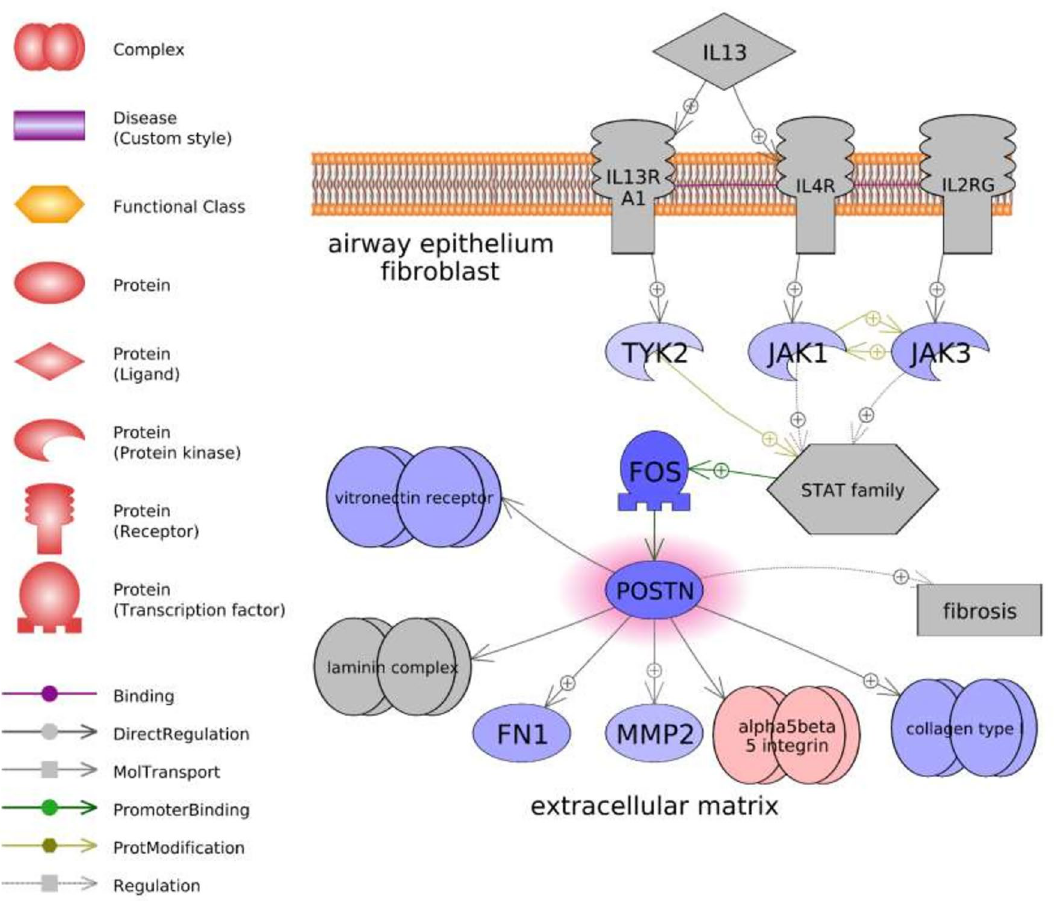
Figure 5. Periostin ( postn )-associated network identified in the ovary following PNX treatment. Red indicates an upregulated gene in the network (darker shade indicates greater log2 fold change compared to control), while blue indicates a downregulated gene. Shapes and arrows are identified in the legend to the left. This is a proposed mechanism based only on transcriptomic